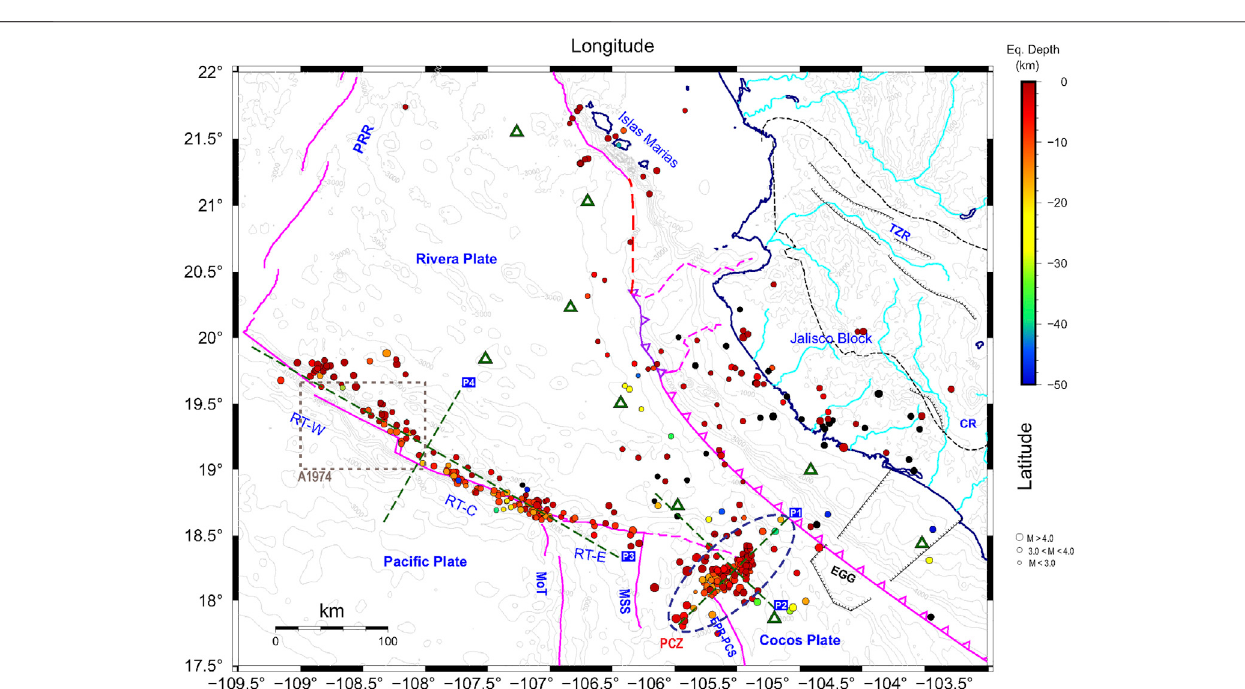
FIGURE 7 | Hypocentral map of the seismicity recorded from May 1 to October 17, 2016, using OBS (green triangles) database and relocated with Hypo-71 and SVR01P-wavevelocitymodel.TheA1974grayrectangledenotesthepositionofthestudyarea(a)reportedforProtheroandReid(1982).Thebluedashedellipseshows thePaci fi c-Cocoszone(PCZ).GreendashedlinescorrespondtotheprojectionofseismicityalongP1,P2,P3,andP4lines(see Figure8 ).Abbreviationsasfor Figure1 . RT-W, RT-C, and RT-E represent the three active segments of Rivera Transform from west to east. PRR, Paci fi c-Rivera rise. exhibits three active segments, or seismogenic zones, from east to west.